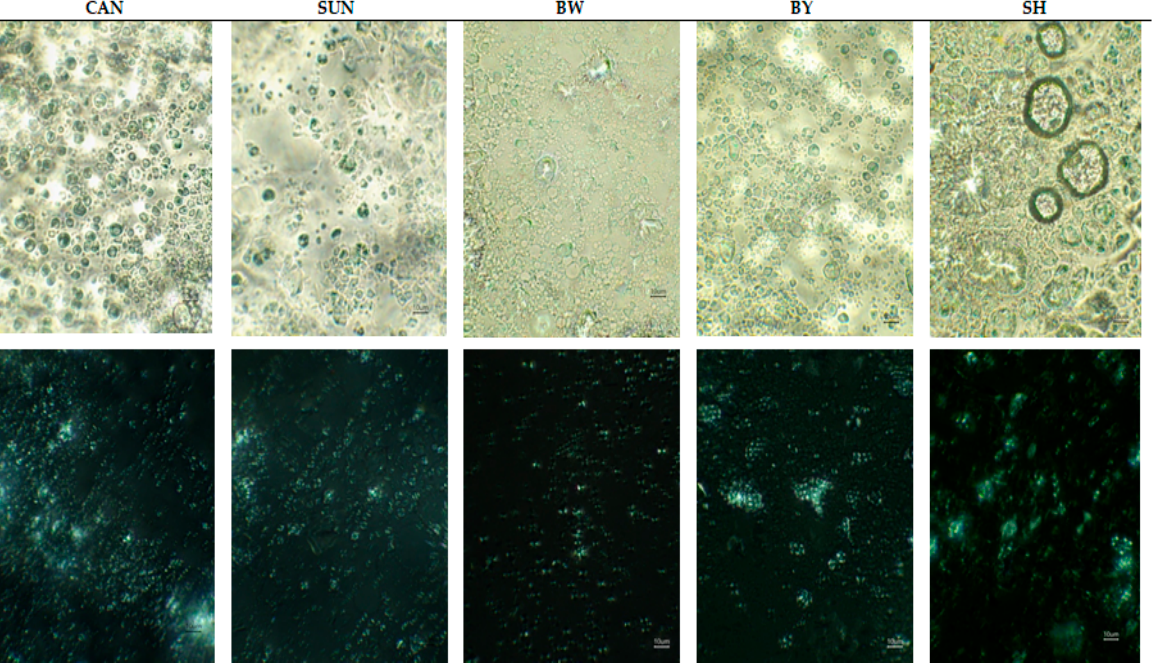
Figure 2. Microstructure of dough of gluten-free muffins, which contained shortening (SH) or oleogel with candelilla (CAN), sunflower (SUN), beeswax white (BW), or beeswax yellow (BY) as the fat component, as observed in bright field ( images at the top—1 ) and polarized light ( images at the bottom—2 ) in 600× magnification.